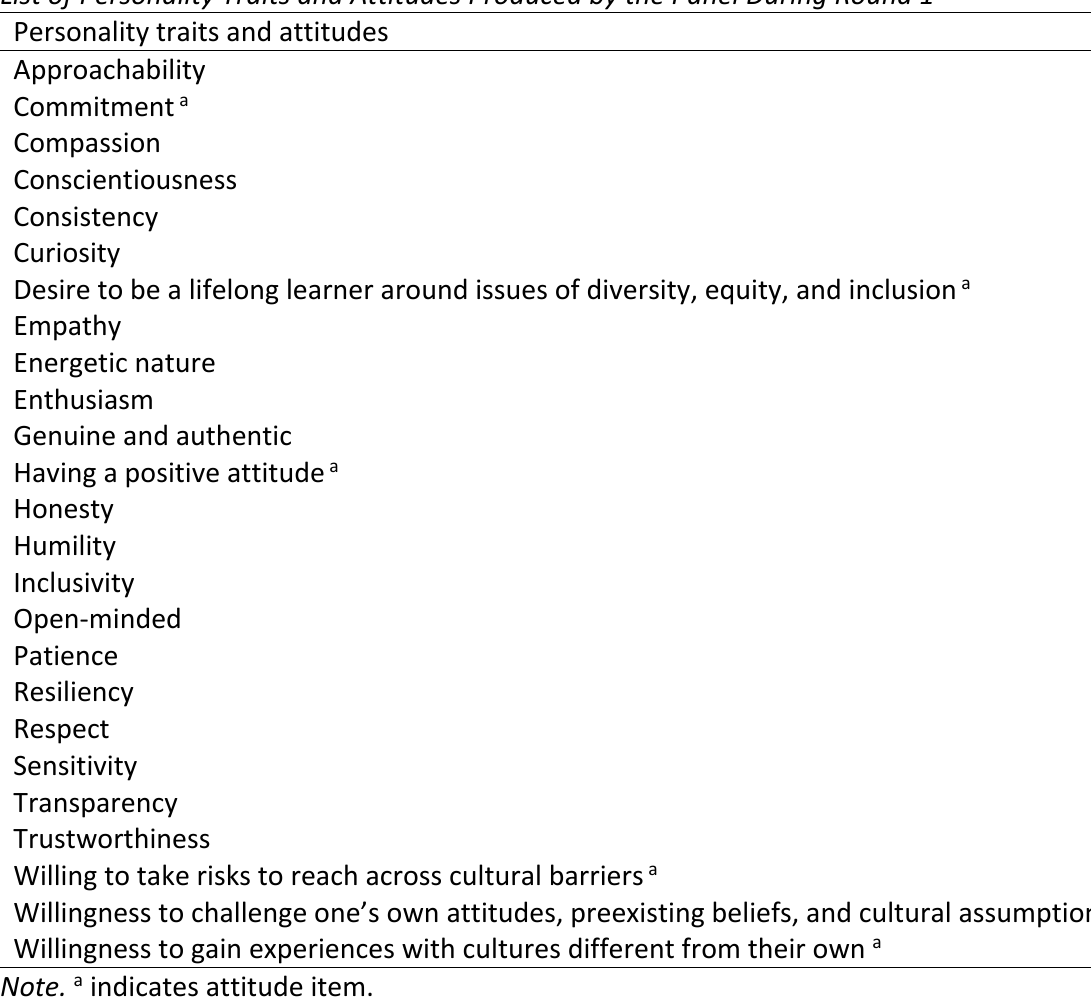
List of Personality Traits and Attitudes Produced by the Panel During Round 1 Personality traits and